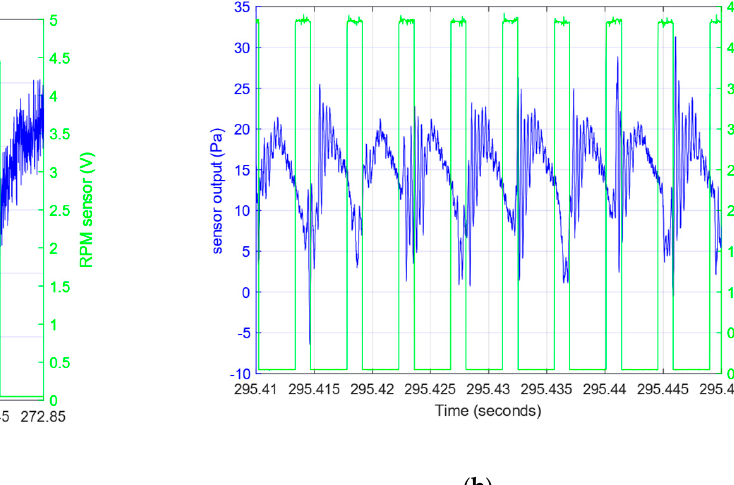
Figure 4. Samples of the recorded pressure responses (2970 and 6750 RPM) (blue) and pulses of the laser RPM meter (green), obtained with ( a ) 2970 RPM, ( b ) 6750 RPM. The specificity of the measurement conditions and requirements demands an appropriately wide bandwidth. A simple analysis was performed. Assuming that a two-blade propeller ( NB = 2) is under test and the rotation achieves n = 10,000 RPM, the basic frequency of pressure pulses is given by Equation (1). Since the purpose of the test is to determine the shape of the pulses, the measurement system bandwidth should be significantly